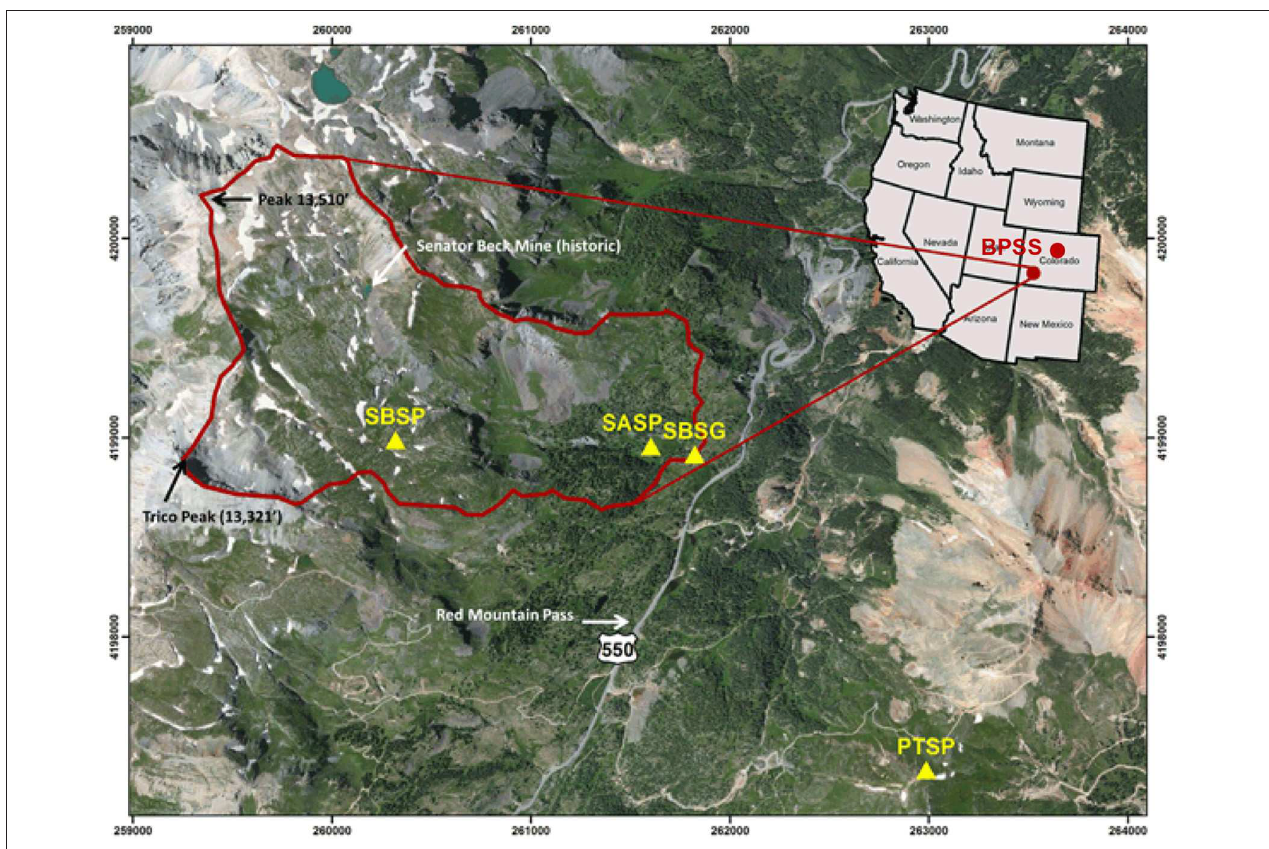
FIGURE 1 | Map from the Center for Snow and Avalanche Studies indicating sample site locations in Colorado, USA (http://snowstudies.org/sbbsa1.html). The Senator Beck Study Plot (SBSP), Swamp Angel Study Plot (SASP), and associated Senator Beck Stream Gauge (SBSG) and Putney Study Plot (PTSP) are indicated by yellow triangles within the Senator Beck Basin (SBB). Samples were collected at the Swamp Angel Study Plot and at the top of Berthoud Pass, in the northwest portion of the state, denoted by BPSS.